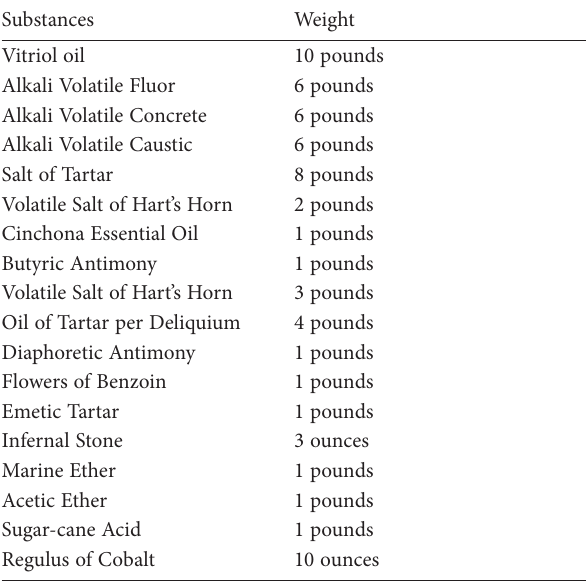
Table 1. Peter Leopold’s order of chemicals purchased from Jean Antoine Claude Chaptal. 4 November